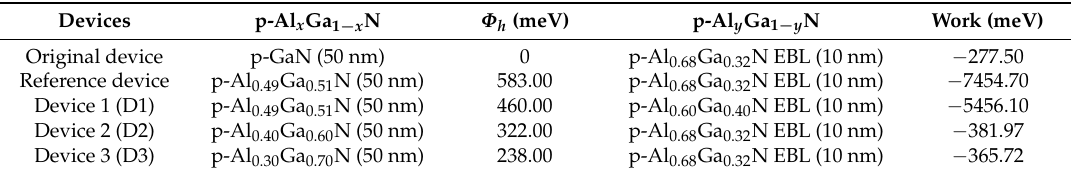
Figure 6. ( a ) Schematic DUV LED structure for the Original device that has no p-Al x Ga 1- x N layer; ( b ) schematic DUV LED structures for the Reference device, Device 1 (D1), Device 2 (D2) and Device 3 (D3); ( c ) numerically calculated electric field profiles in the hole suppliers for the studied DUV LEDs, and ( d ) summarized optical output power for the five investigated DUV LEDs. Detailed AlN compositions of the p-EBLs and the p-Al x Ga 1- x N layers for the studied devices are shown in Table 1. Figure 6a–c are reproduced from Ref. [72], with the permission of Optical Society of America. Figure 6d is summarized according to the reported values in Ref. [72]. Table 1. AlN compositions of the p-EBLs and the p-Al x Ga 1- x N layers, values of the Ø h and the work ( W ) that is conducted on the holes by the respective electric field reservoir for all the studied DUV LEDs. Reproduced from Ref. [72], with the permission of Optical Society of America.